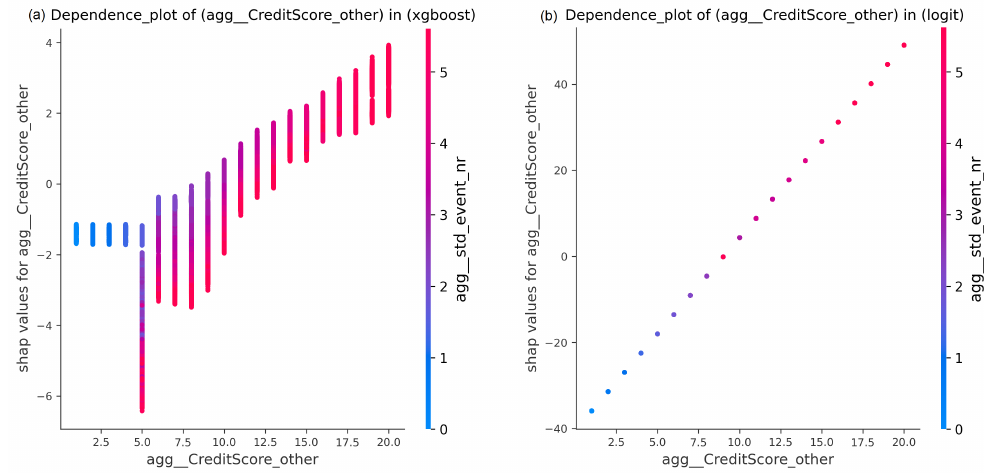
Figure 4. SHAP Dependence plots of BPIC2017_Refused (single aggregation) event log.